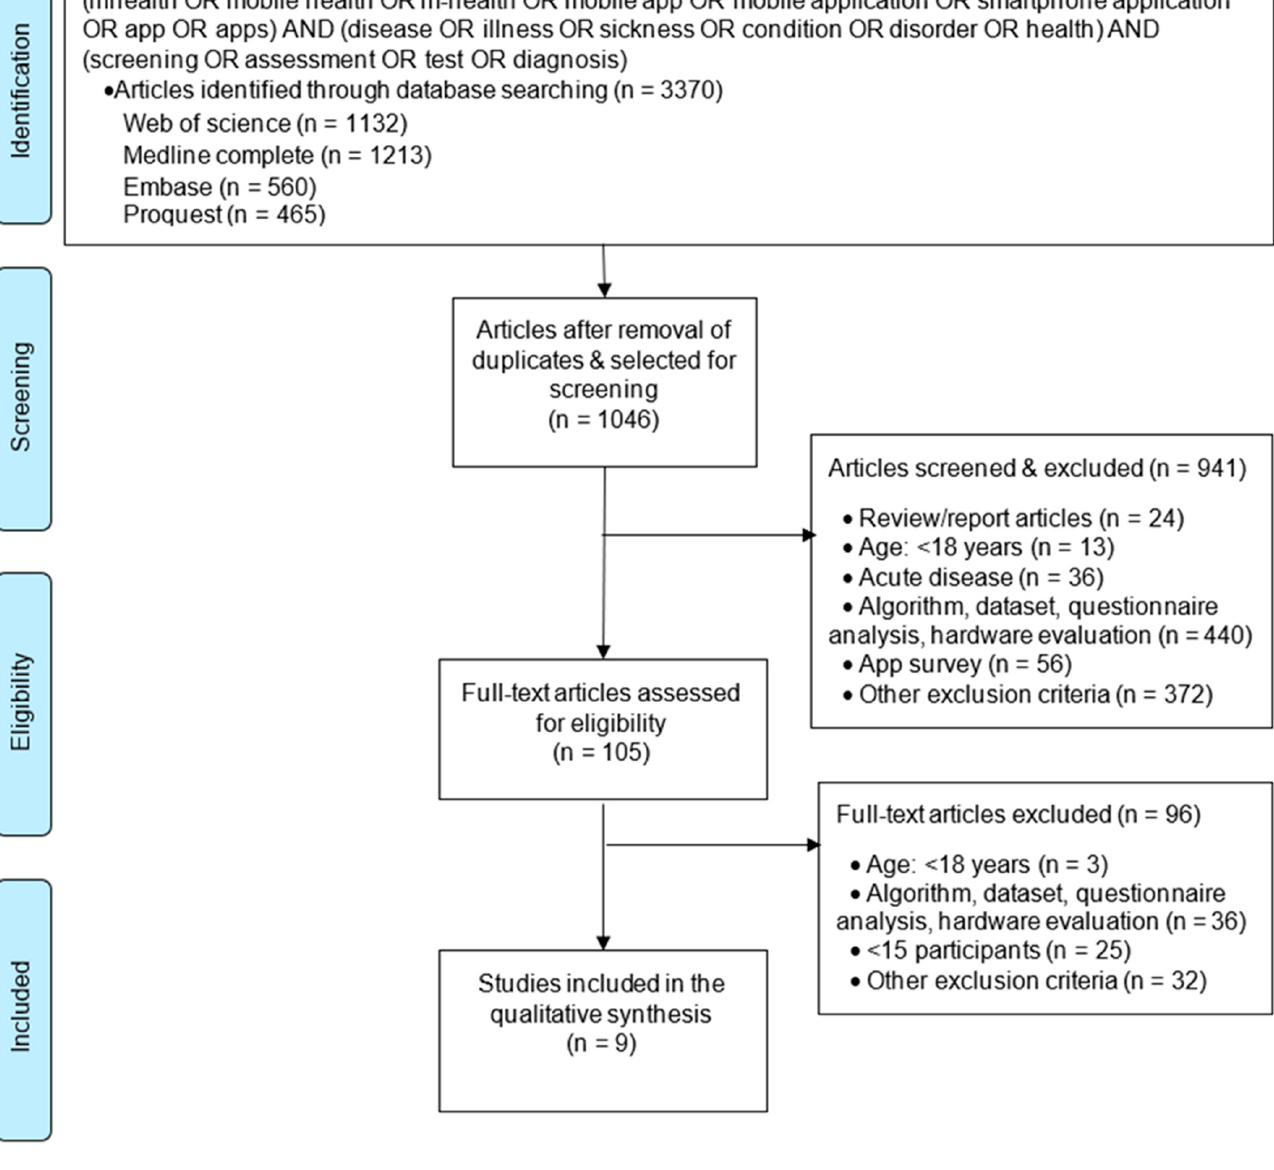
Figure 1. Flow diagram for selection of articles (adapted from [11]).